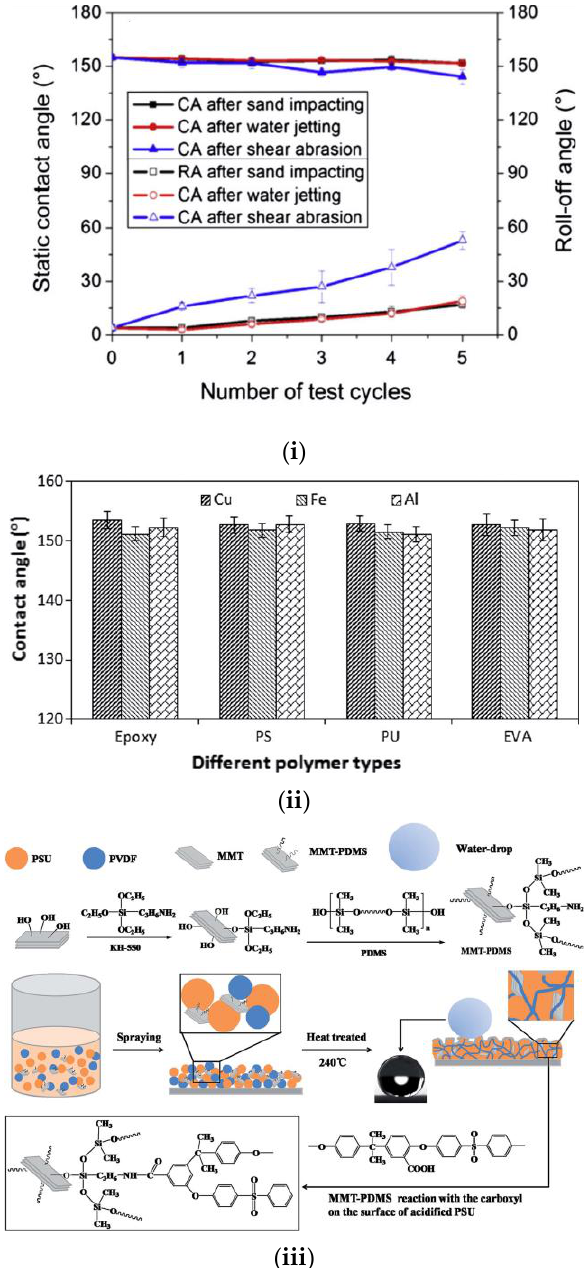
Figure 13. Spray coating of a superhydrophobic material. ( i ) Static and roll-off contact angles on functionalized silica nanoparticle coated etched aluminum alloy after repeated mechanical tests. In the water jetting tests, the samples were jetted at 25 kPa for 10 min. Reproduced with permission from [89]. ( ii ) The WSCA at optimum silica percentage (2.5 wt%) with optimum polymer percentage (2 wt%) using different polymer types at various metallic substrates. Reproduced with permission from [91]. ( iii ) Schematic representation of the preparation method of superhydrophobic polysulfone/polyvinylidene/montmorillonite/polydimethylsiloxane (PSU/PVDF/MMT-PDMS) composite coatings, as described by Wang et al. Reproduced with permission from [92].